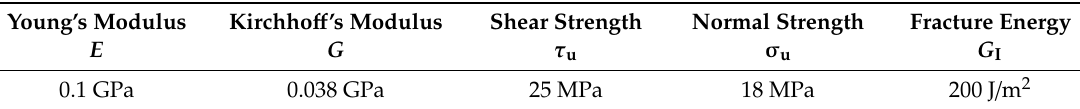
Table 3. Material properties of epoxy adhesive [24].